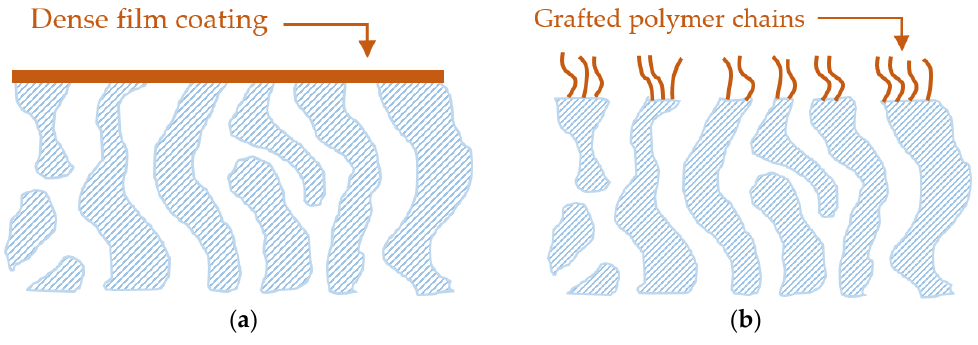
Figure 2. Schematic of membrane surface modification to enhance antifouling properties. ( a ) Coating of a thin nonporous dense film; and ( b ) grafting of polymer chains on top of membranes.